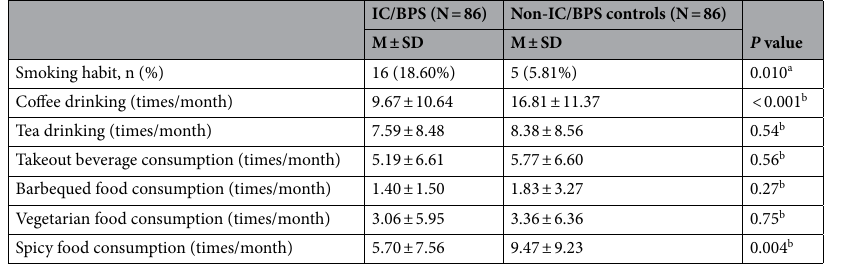
Table 3. Comparison of smoking, tea, coffee, and spicy food consumption habits. M mean, SD standard deviation. a Chi-square test, b t test.